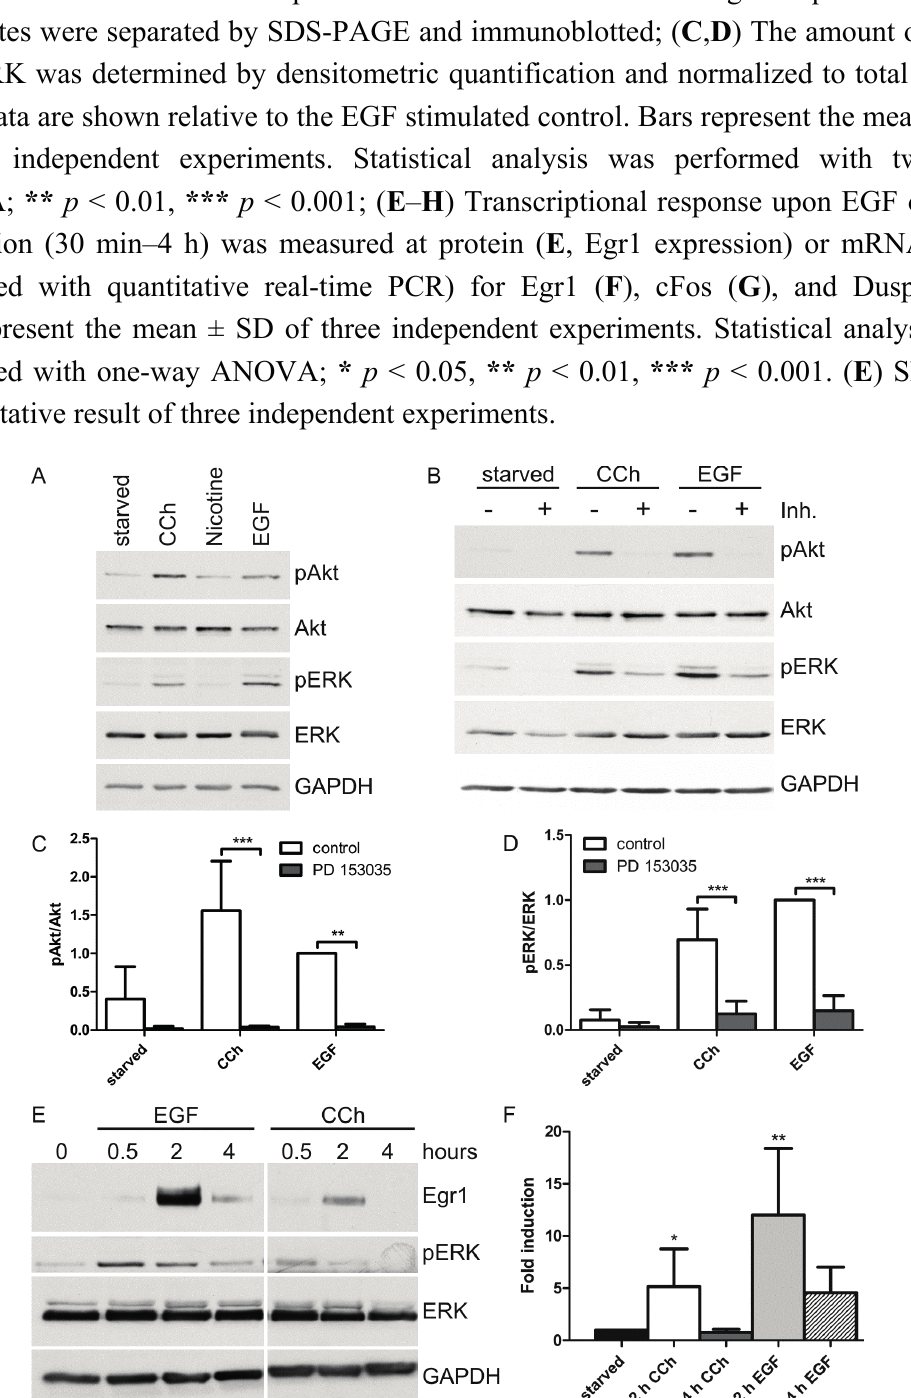
Figure 1. Inhibition of epidermal growth factor receptor (EGFR) kinase activity prevents cholinergic activation of Akt and extracellular signal regulated kinase